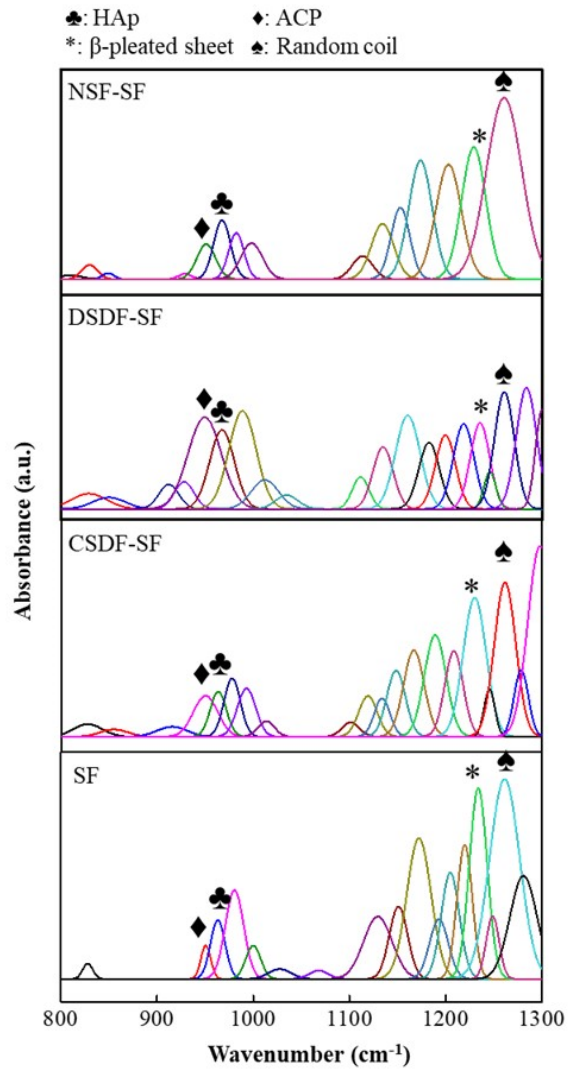
Figure 6. FTIR-ATR spectra of the silk-fibroin-based membranes after the biomineralization process in 10 × SBF for 24 h, showing the HAp and ACP peaks. Table 2. Table for crystallinity index of HAp, silk fibroin, and its FWHM (unit: %), in the SF-based biomineralized samples.